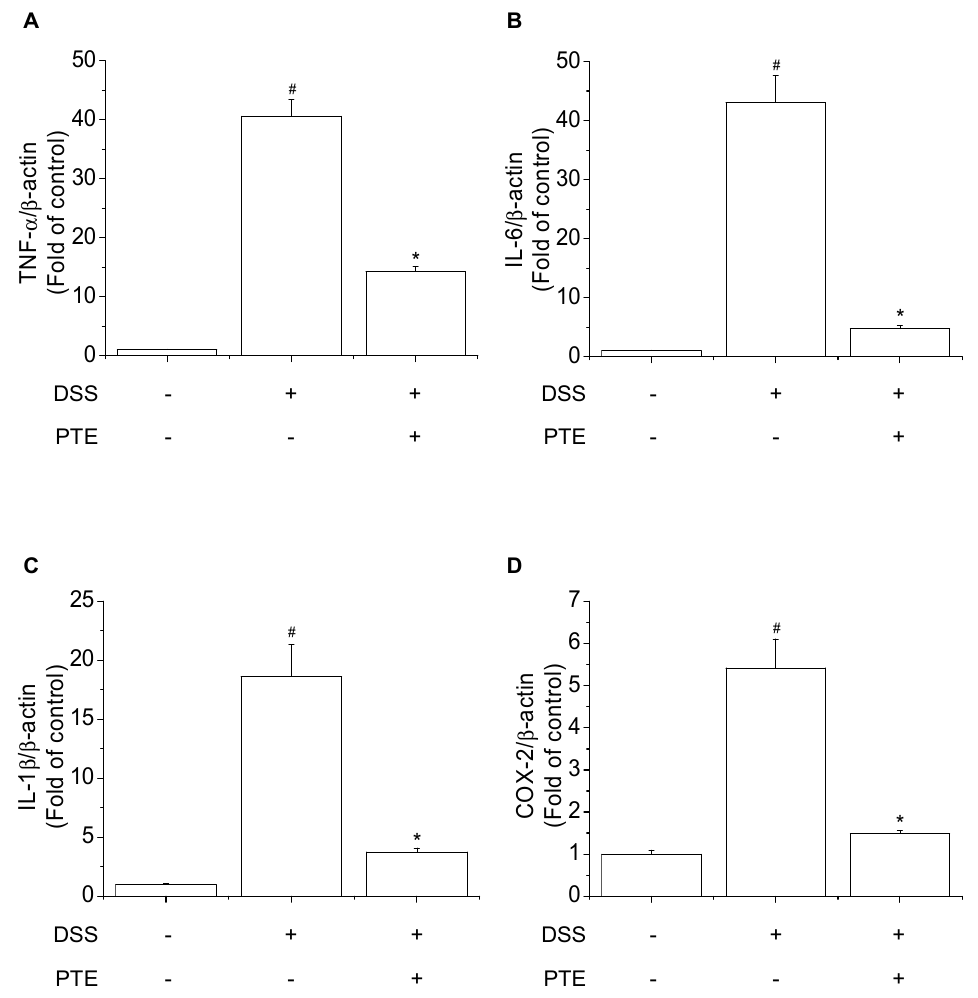
Figure 3. Effects of PT extracts on inflammatory markers in colon of DSS-treated mice. The mRNA expression of inflammatory markers was determined by real-time PCR primer of ( A ) TNF- α , ( B ) IL-6, ( C ) IL-1 β , and ( D ) COX-2 in colon of DSS-treated mice. All results are expressed as the means ± SD (n = 10). Compared with Control group, # p < 0.05, Compared with DSS group, * p < 0.05. Control, DSS, and PTE indicated normal group, DSS-treated group, and DSS plus PT extracts-fed group, respectively.